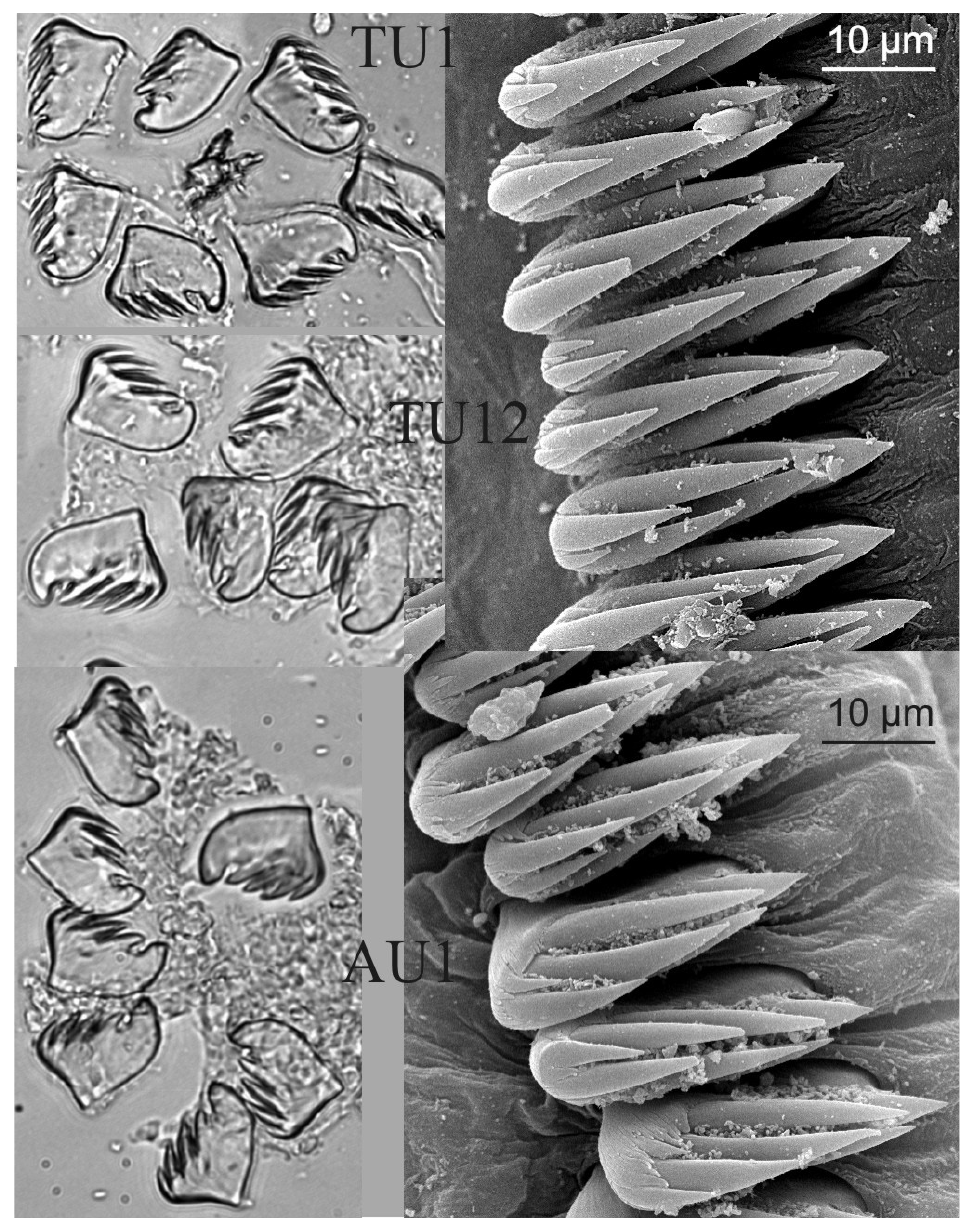
Fig. 3. Amage giacomobovei sp. nov., uncini. Uncini of appropriate chaetigers (TU1, TU12, AU1), compound microscope (MNA-07931) and SEM (MNA-06377) photos. Abbreviations: see Material and